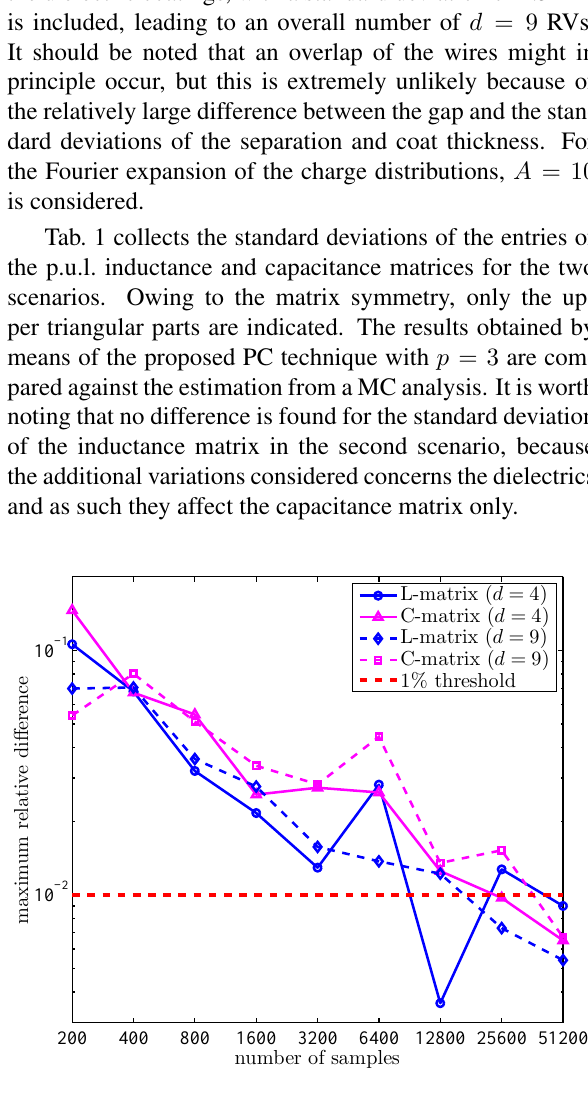
Figure 3: Convergence of the MC simulation for the stan- dard deviation of the p.u.l. parameters of the ribbon cable.